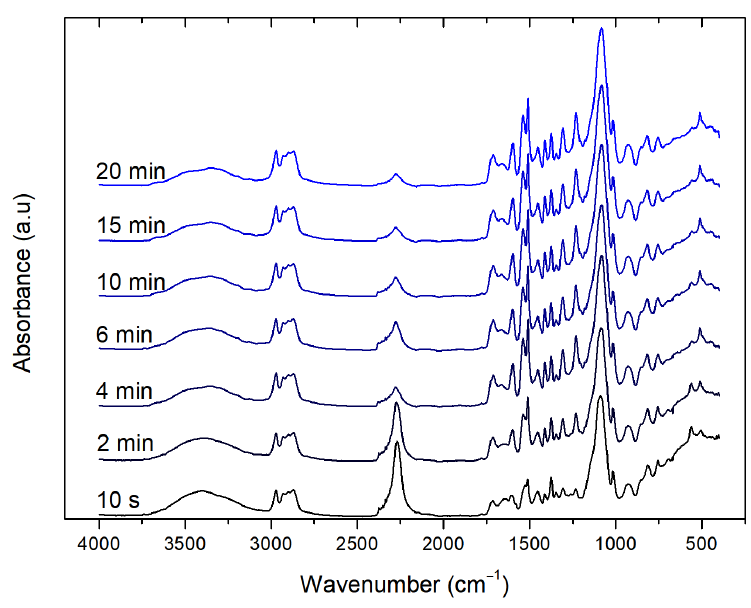
Figure 2. Representative FTIR spectra of PUF B0.2 formulation with time.